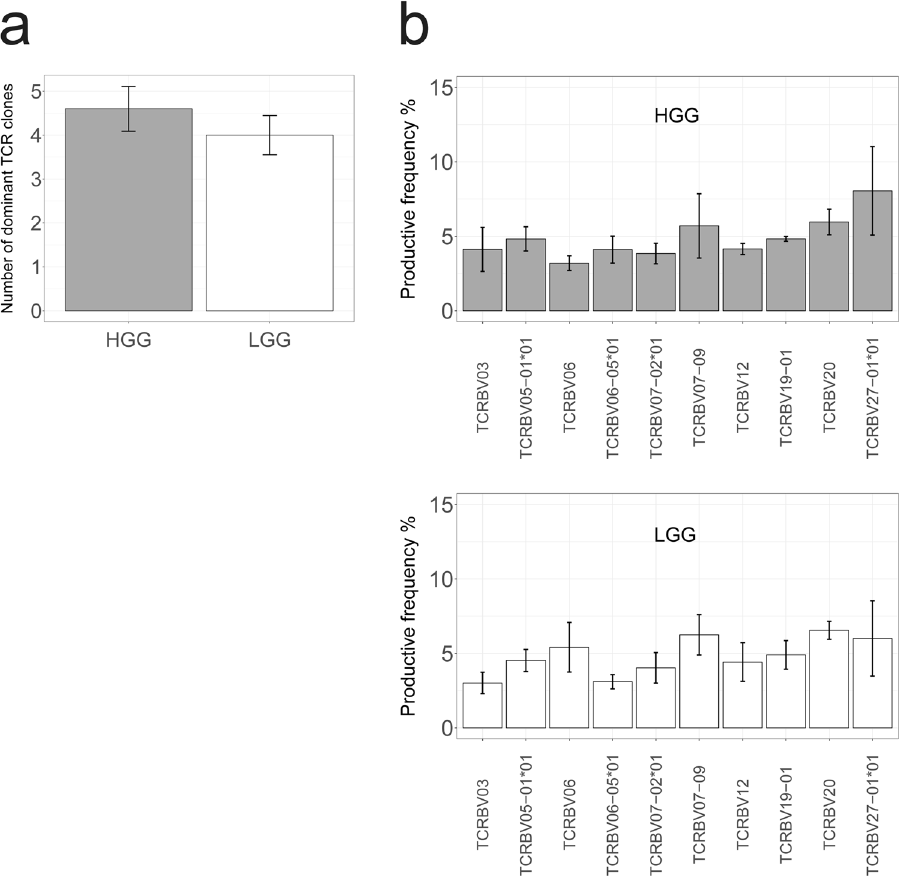
Figure 4. TCR repertoire appears diverse in HGG and LGG, showing no difference in V β dominance. TIL- derived DNA of HGG (n = 5) and LGG (n = 5) was sequenced for the CDR3 region of the TCR β chain. ( a ) HGG and LGG do not differ in quantity of dominant TCR clones. The average number of dominant TCR clones is determined by the number of TCR-V β genes representing 30% of all V β genes and presented per patient sample. ( b ) HGG and LGG do not differ in quality of dominant TCR clones. The quality of TCR clones is determined by the gene-usage of the 10 most frequent TCR-V β genes and presented for HGG (top) or LGG (bottom). Productive frequency (%) is the fraction of unique TCR-V β reads which do not contain a premature stop- codon. Mann-Whitney U